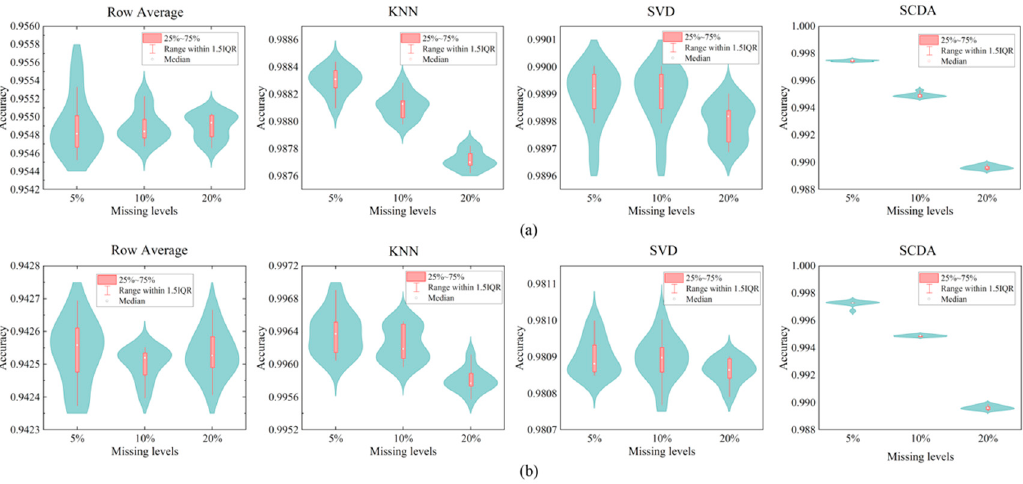
Figure 8. Violin plots of the accuracy values different imputation methods on HLA genotypes at three missing levels. ( a ) Imputation results on HLA genotypes of EAS super population. ( b ) Imputation results on HLA genotypes of the entire human population including five super populations.